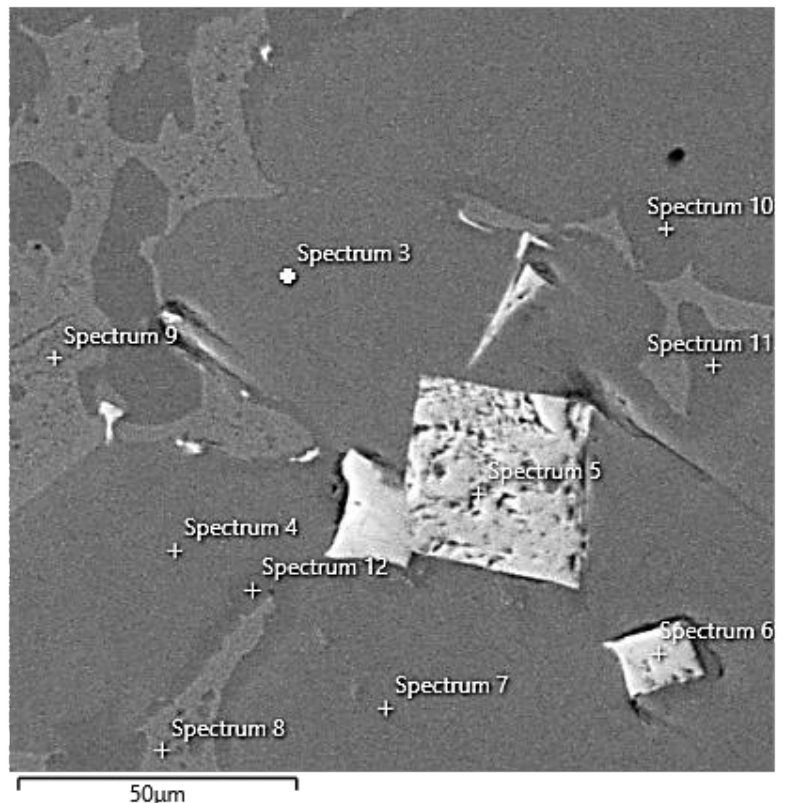
Figure 3. SEM image of Co70W12Al15 alloy with EDS point analysis (Spectra 3 – 12). Table 2. EDS point analysis of Co70W12Al15 alloy.